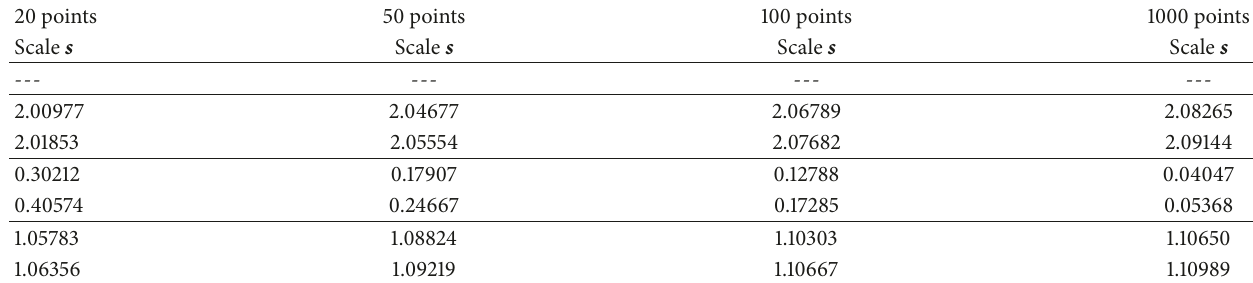
Table 27: Exponential distributions with 30% noise